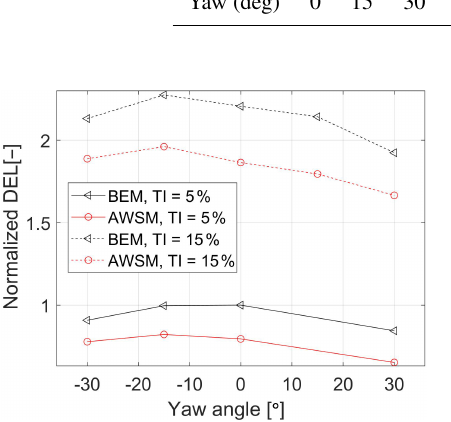
Figure 3. Normalized blade root DEL as a function of yaw angle for the AWSM and BEM models.